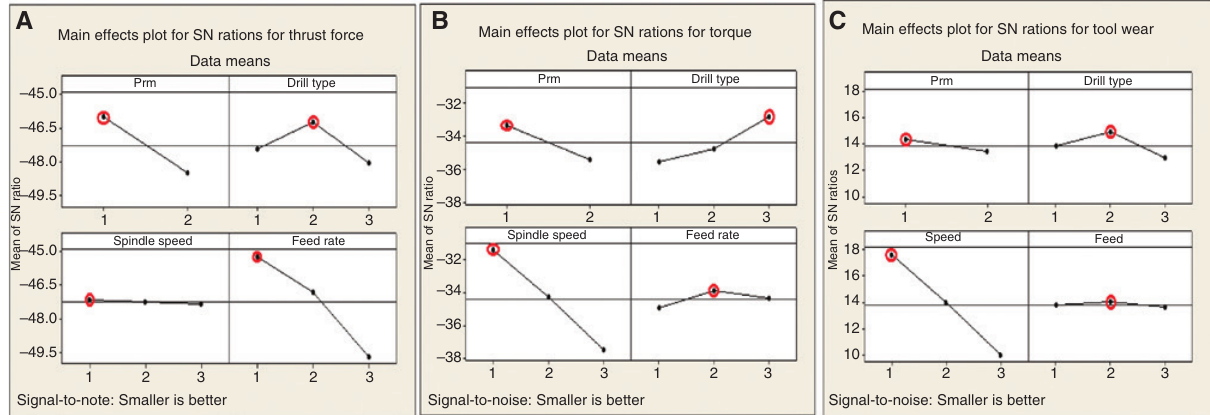
Figure 6: (A) Main effects plot for the S/N ratio for thrust force, (B) main effects plot for the S/N ratio for torque, and (C) main effects plot for the S/N ratio for tool